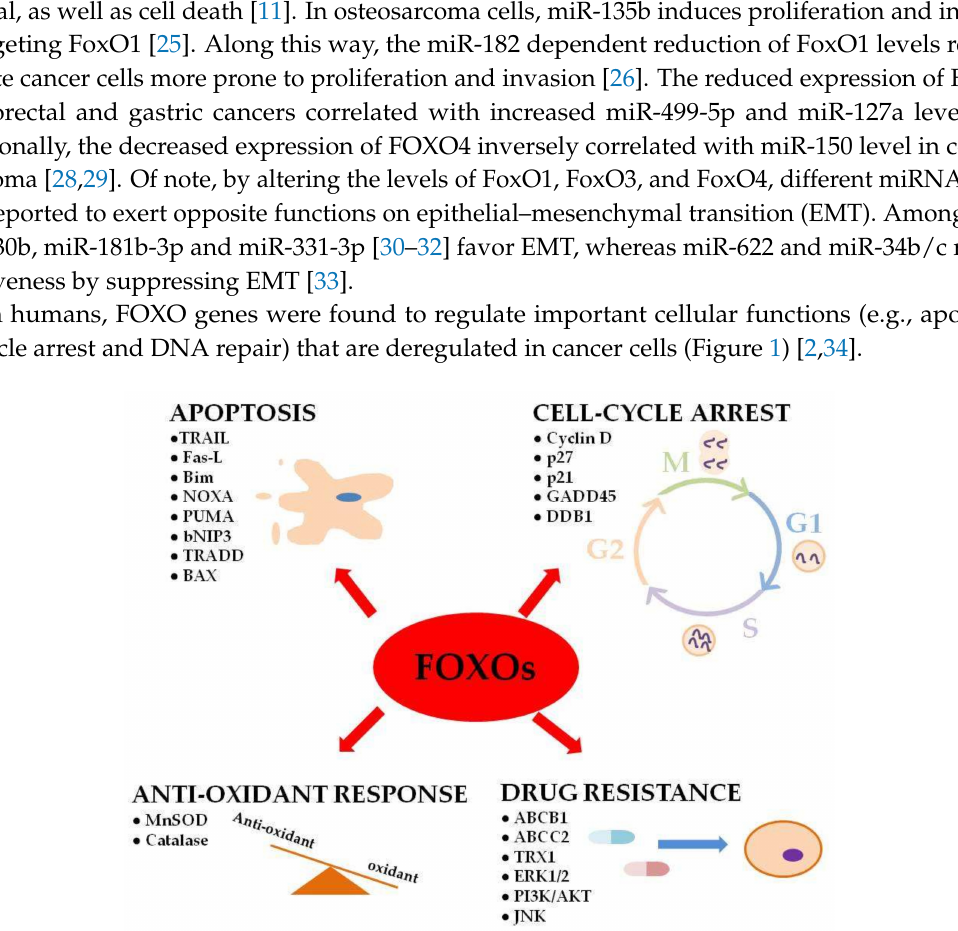
Figure 1. Implication of FoxO (FoxO proteins) functions in physiological processes and drug resistance in